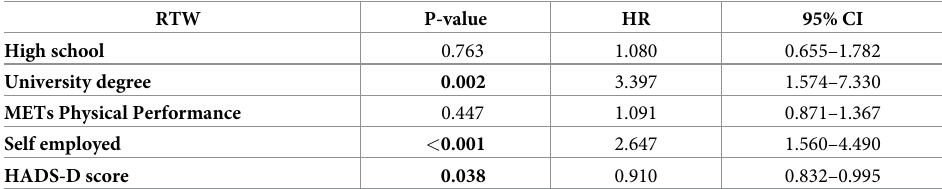
Table 5. Multivariate Cox regression analysis for predictors of return to work status (RTW). RTW P-value HR 95%